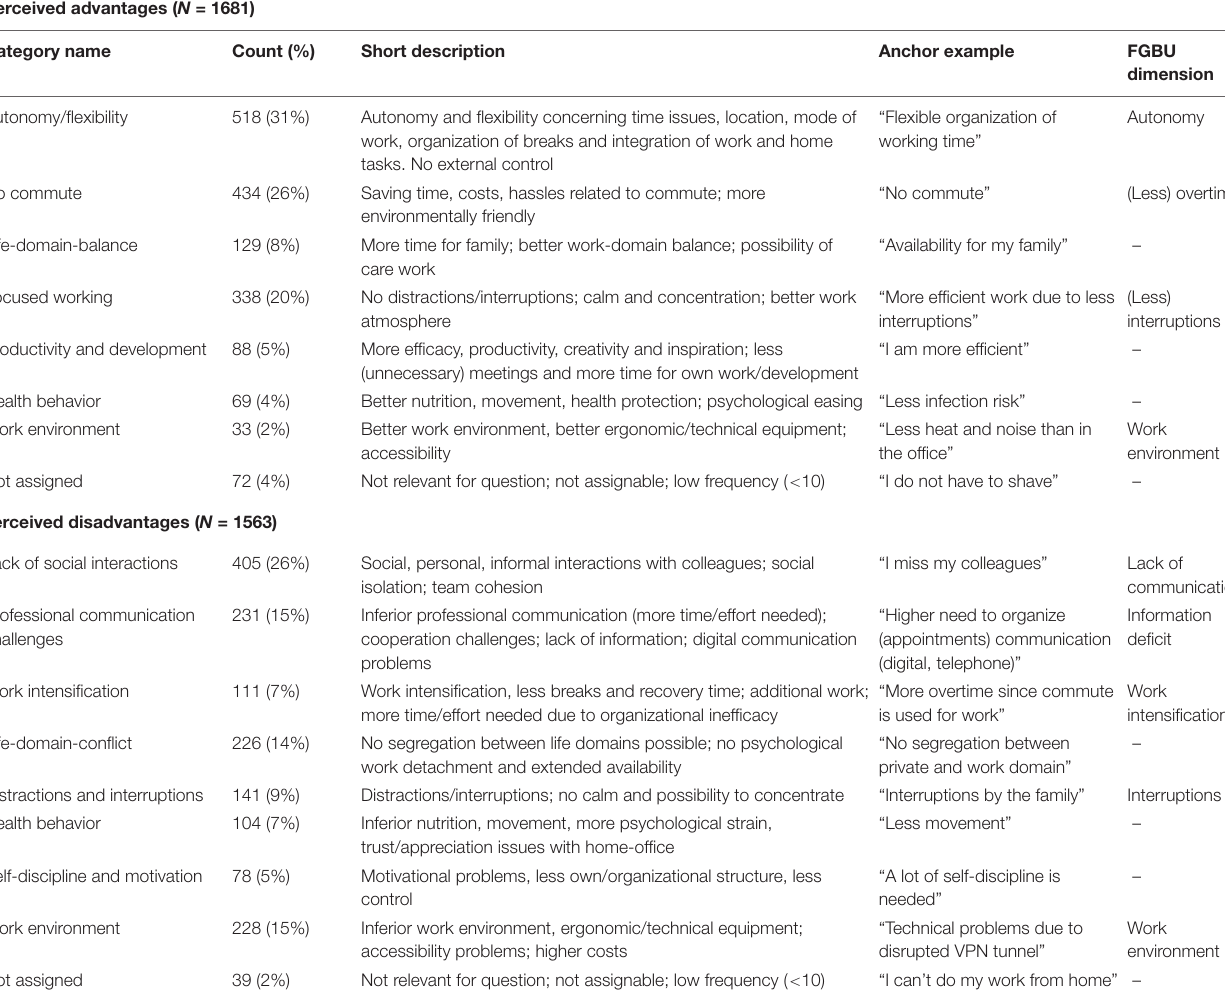
TABLE 1 | Categories of advantages and disadvantages based on the qualitative analysis and assigned FGBU dimension. Perceived advantages ( N = 1681)